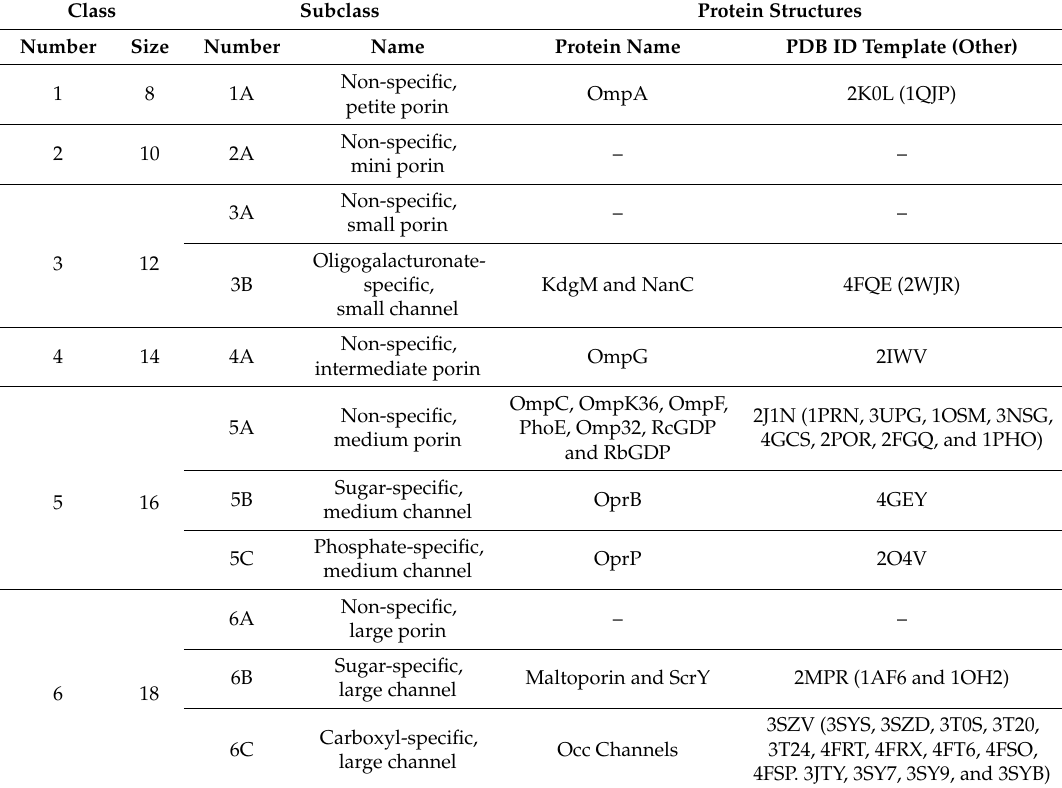
Table 3. The non-specific porin and specific diffusion channel family distributed among six classes and further divided into eight subclasses. Corresponding OMPdb [35] classifications are found in Table S1. The empty classes (and subclasses) are reserved for future structures. “Size” refers to the number of